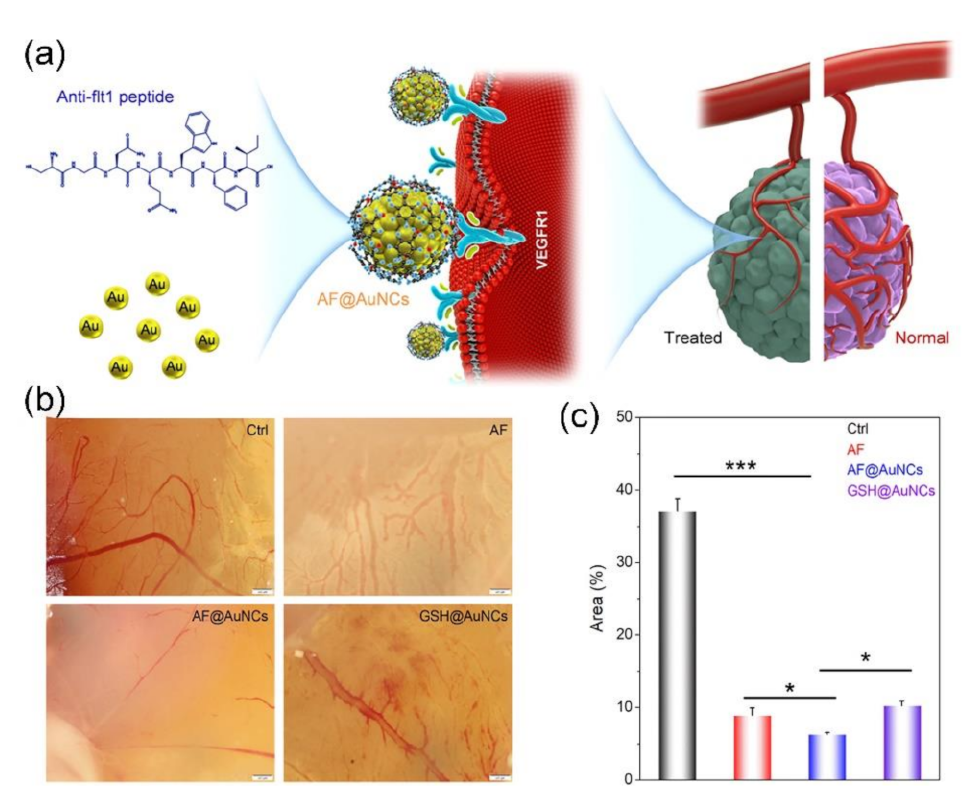
Figure 7. Antiangiogenic cancer therapy by AF@AuNCs. ( a ) Schematic illumination of Anti-Flt1 peptide templated AF@AuNCs for antitumor angiogenesis, ( b ) inhibition of CAM